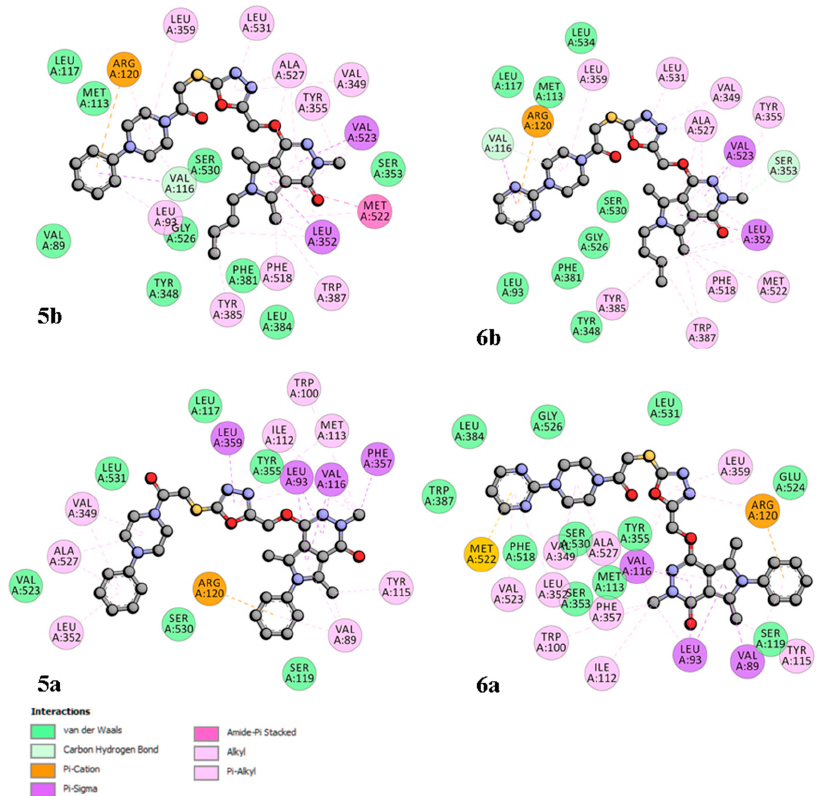
Figure 3. 2D interaction plot of 5a , 5b , 6a , 6b with COX-2 .